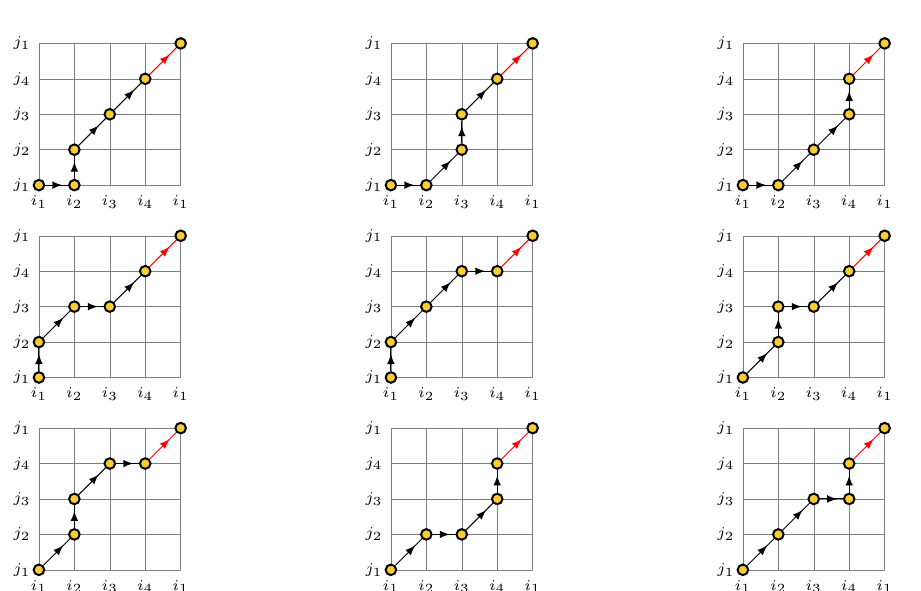
Figure 14. The 9 terms in W PQ coming from both T P and T Q quartic. Red arrows represent the products of a field in p and a field in q . Black arrows descend from fields that are not in p or q .